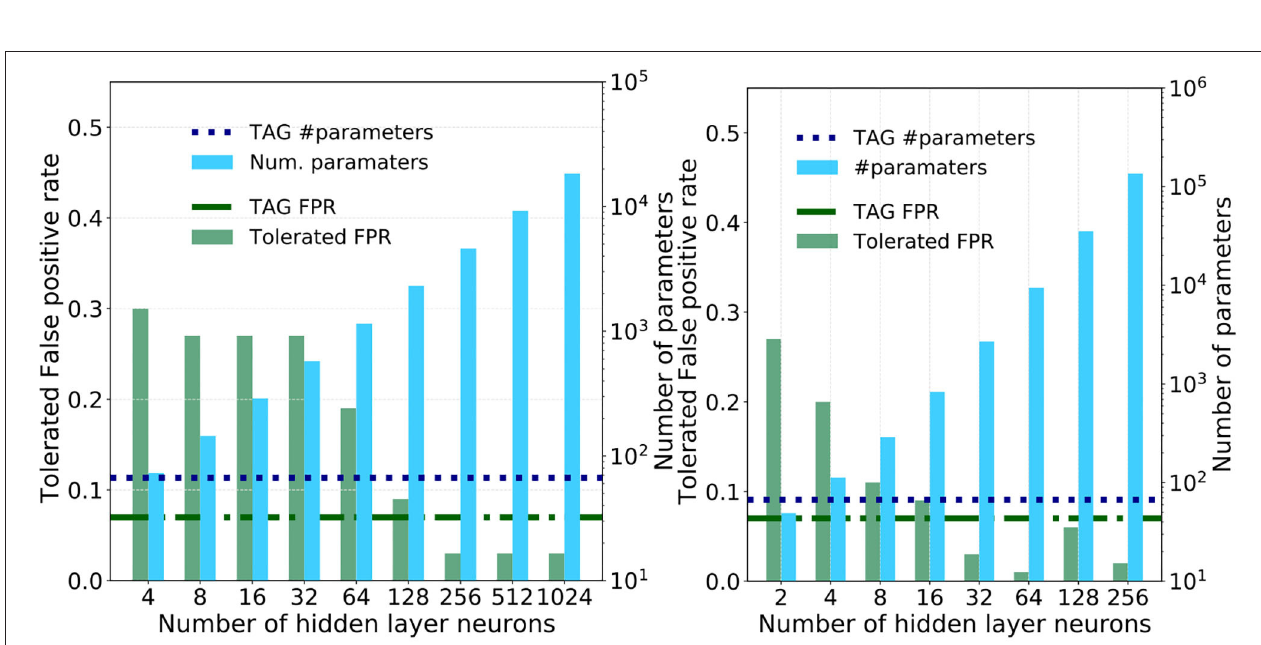
FIGURE 7 | The performance of the single and three hidden-layer multi-layer perceptrons used as a means of comparison against the TAG model. (A) Pairs of bar plots over a range of hidden layer sizes for a single MLP. The bars show the tolerated FPR (green bars, left y-axis) and the number of parameters required by the model version (blue bars, right y-axis). Dashed horizontal lines show (green) the TAG model tolerated FPR and (blue) the number of parameters required in the TAG model. The minimum TPR is 0.95. (B) Pairs of bar plots over a range of hidden layer sizes for a three hidden layer MLP. The bars show the tolerated FPR (green bars, left y-axis) and the number of parameters required by the model version (blue bars, right y-axis). Dashed horizontal lines show (green) the TAG model tolerated FPR and (blue) the number of parameters required in the TAG model. The minimum TPR is 0.95.